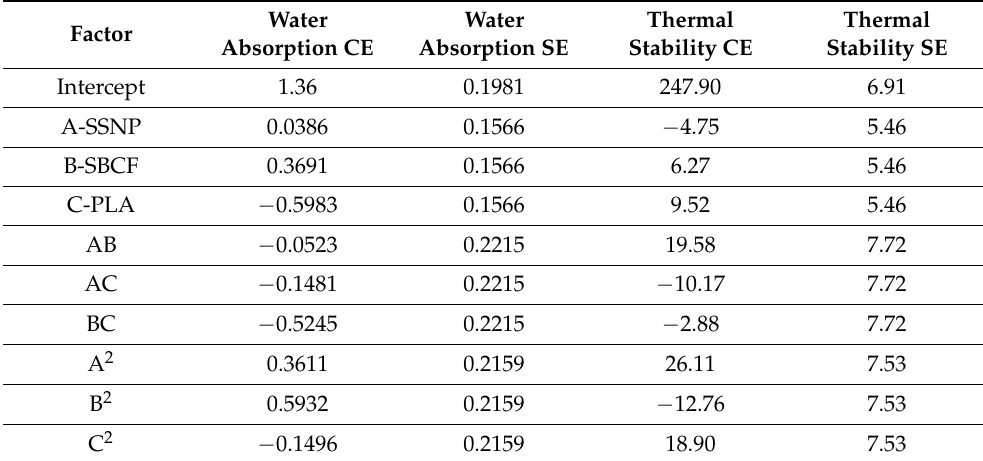
Table 4. Coefficients of estimates with standard errors for the model.